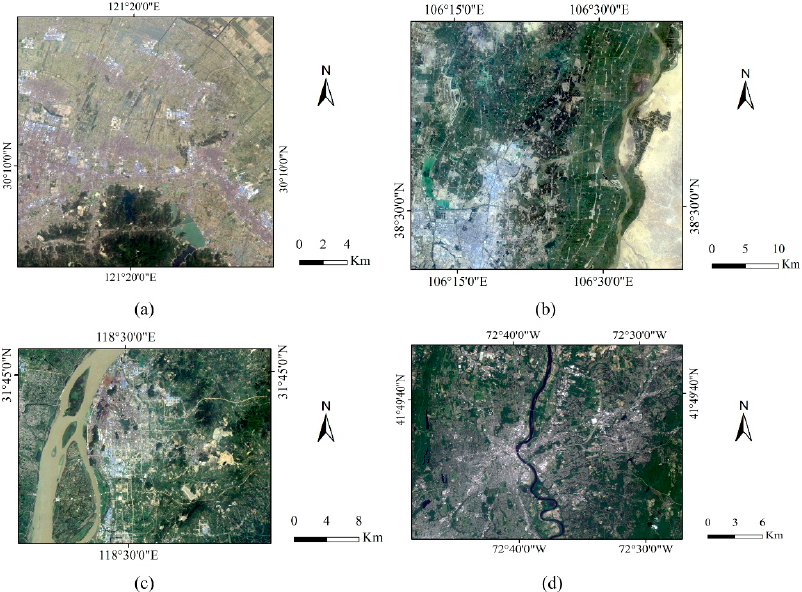
Figure 1. Landsat 5 images used in case studies: ( a ) a part of Cixi city, Zhejiang, China; ( b ) a part of Yinchuan city, Ningxia, China; ( c ) a part of Maanshan city, Anhui, China; ( d ) a part of Hartford, CT, USA.